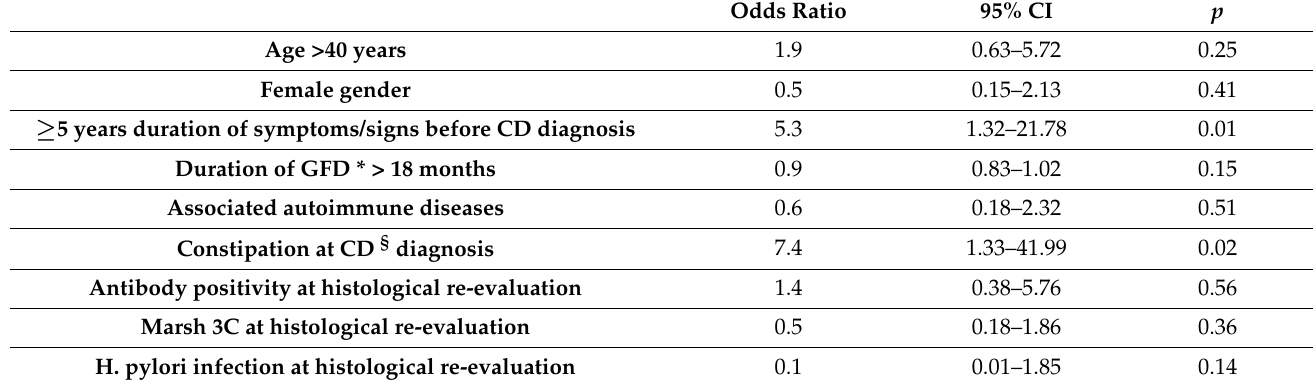
Table 4. Variables associated with the persistence of symptoms/signs at the time of histological re-evaluation in the logistic regression